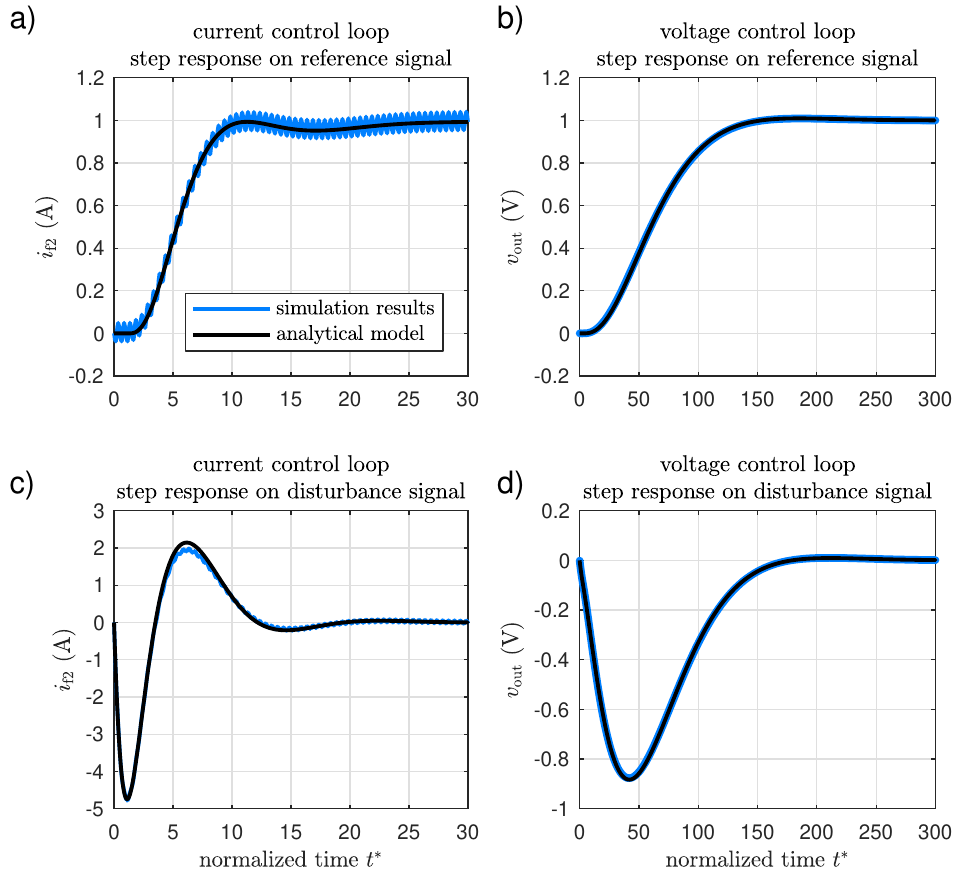
Figure 13. Comparison of the control system responses obtained with numerical simulation model and analytical models presented in this paper: ( a ) current control loop, step response on reference signal, ( b ) voltage control loop, step response on reference signal, ( c ) current control loop, step response on disturbance signal, ( d ) voltage control loop, step response on disturbance